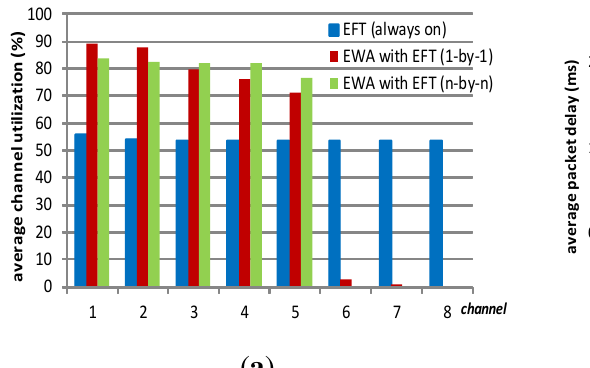
Figure 8. Average channel Utilization & Average packet delay. ( a ) Average channel Utilization; ( b ) Average packet delay of ONUs of each